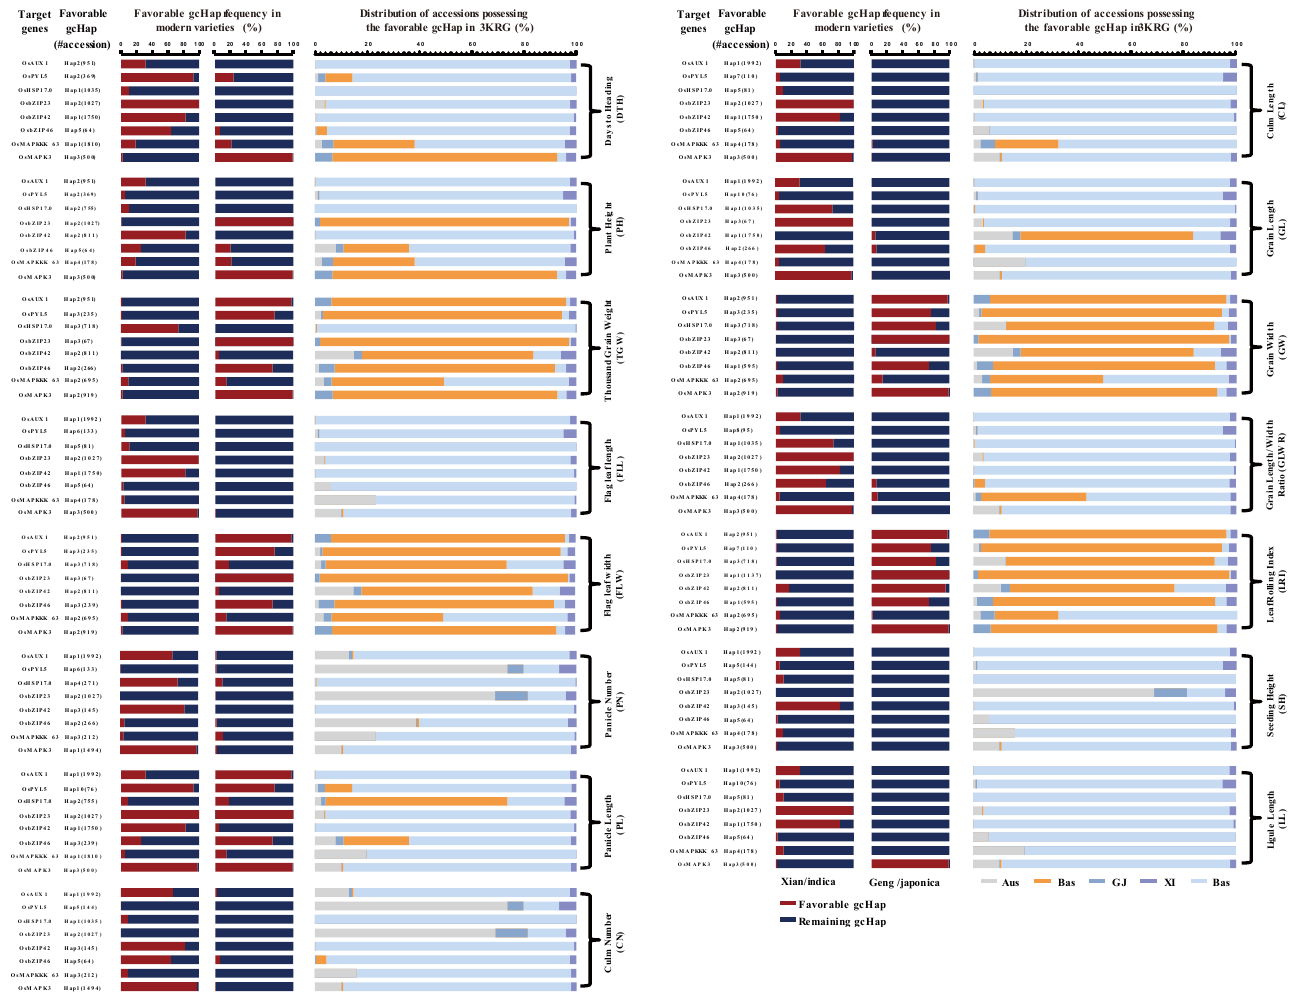
Figure 2. Frequencies of the “favorable” gcHaps of nine drought and salt co-response genes affecting fifteen yield traits (DTH, PH, TGW, FLL, FLW, PN, PL, CN, CL, GW, GLWR, LRI, SH and LL) in Xian / indica (XI) and Geng / japonica (GJ) modern varieties and different rice populations. From these results, nine DT and ST co-response genes had favorable gcHaps dis- tributed in the Xian , Geng , Aus , Basmati ( Bas ), and Admixtures ( Admix ) populations in